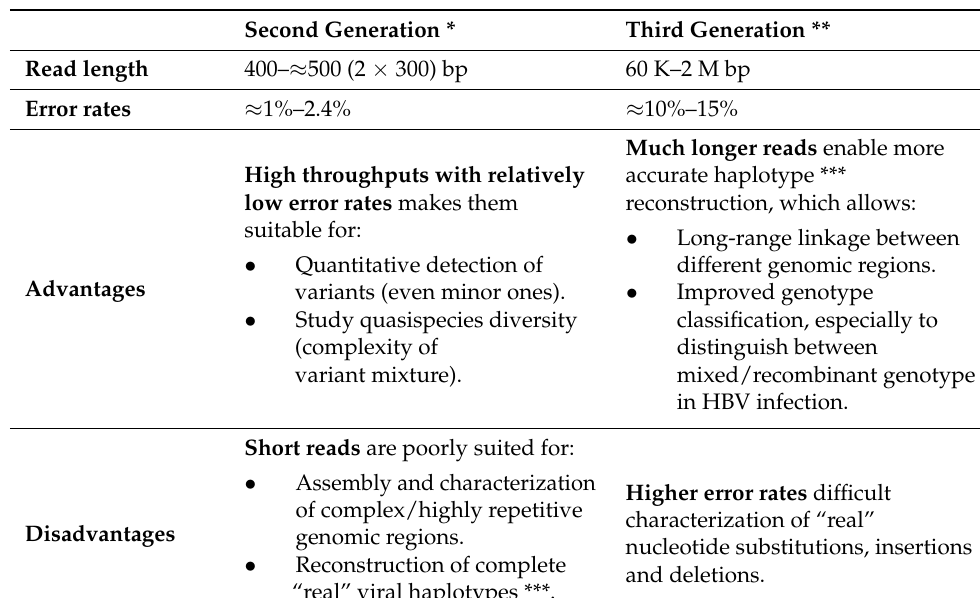
Table 2. Comparison between second and third generation sequencing methodologies. Advantages and drawbacks [158]. * Taking Ion Torrent Personal Genome Machine and Illumina MiSeq platforms as examples. ** Taking Pacific Biosciencies RSII and Oxford Nanopore MinION platforms as